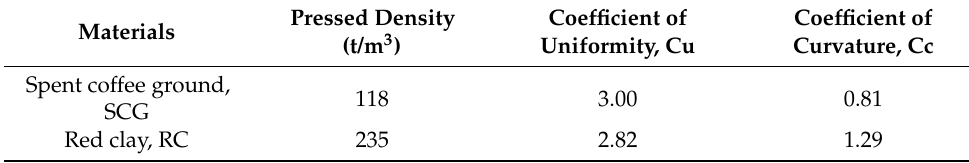
Table 1. Geotechnical properties of the sieved SCG and